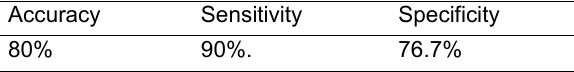
Table 1. Performance Measures for the Proposed